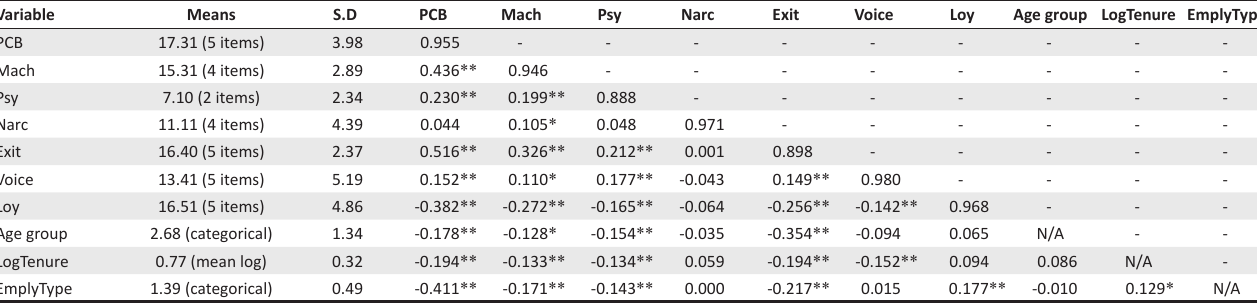
FIGURE 2: Result structure. TABLE 1: Inter-item correlation, means, standard deviation and composite reliability.